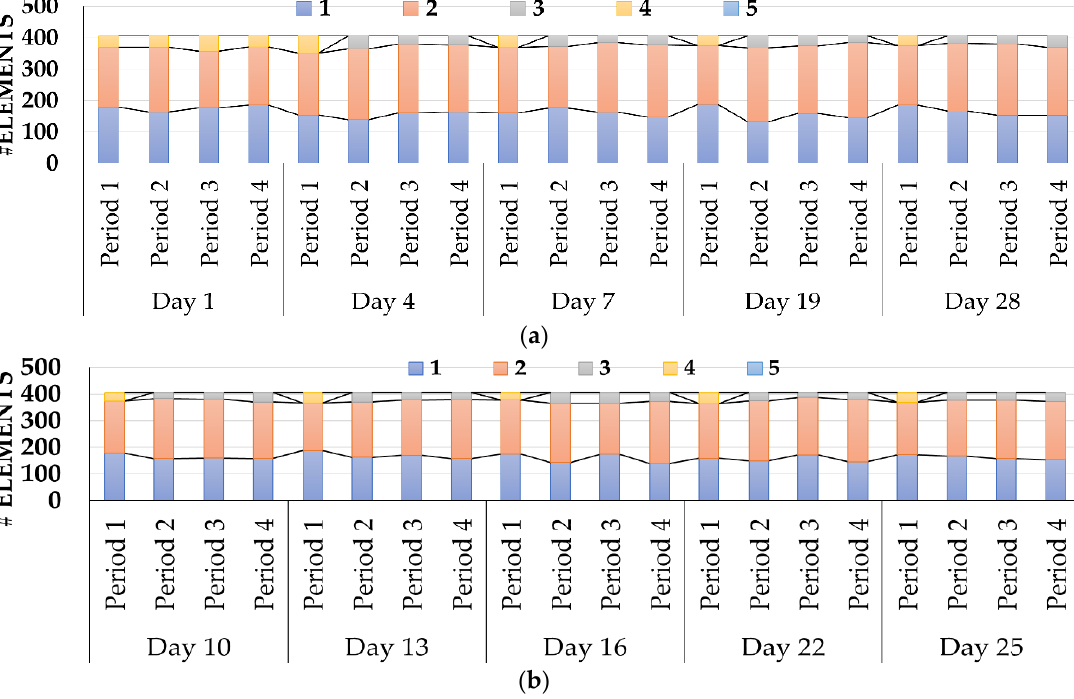
Figure 7. Number of elements per Reliability Rate regarding final rate: ( a ) DR event 1; ( b ) DR event 2.